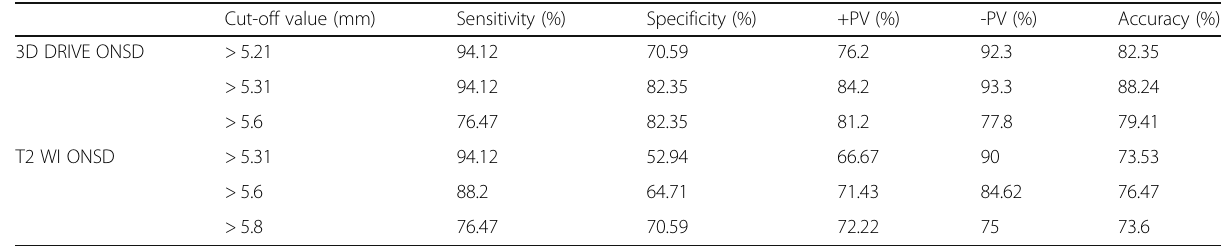
Table 3 The cut-off value of ONSD measured in 3D DRIVE and T2 WI sequences for diagnosing idiopathic intracranial hypertension Cut-off value